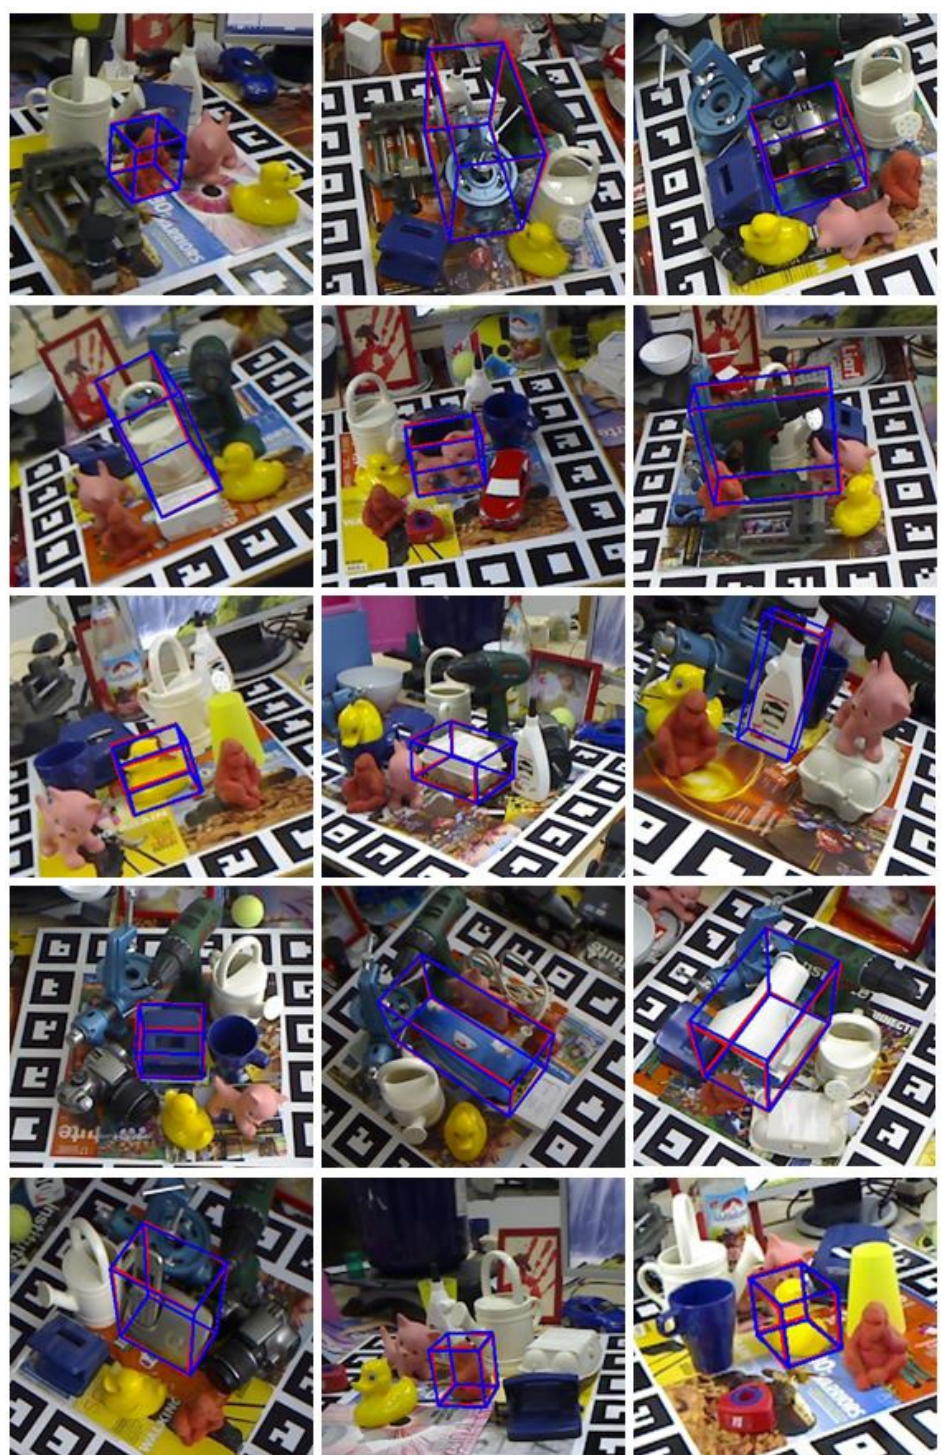
Figure 6. Our method’s results of pose estimation on the LineMod dataset. The ground truth is represented by the blue 3D bounding boxes, while the estimation results are represented by the red 3D bounding boxes.